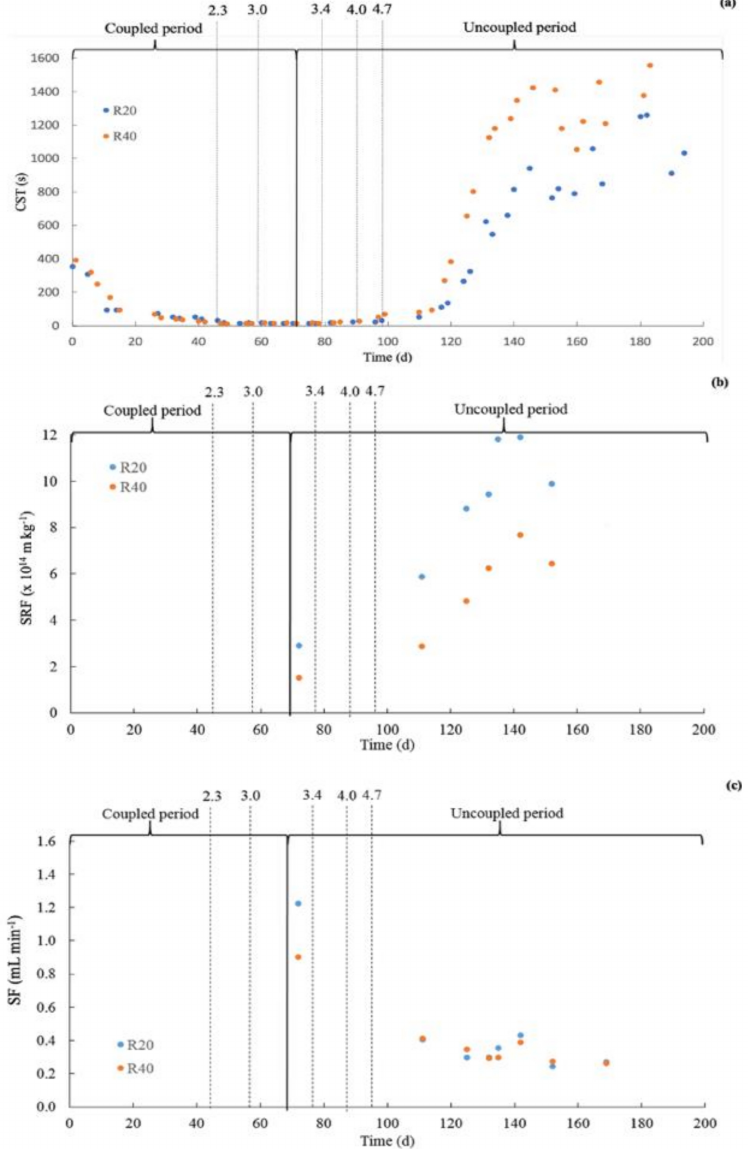
Figure 4. ( a ) Capillary suction time (CST), ( b ) Specific resistance to filtration (SRF), and ( c ) supernatant filterability (SF) for the R20 and R40 reactors over time. The dotted lines indicate the applied OLR (g COD/(L